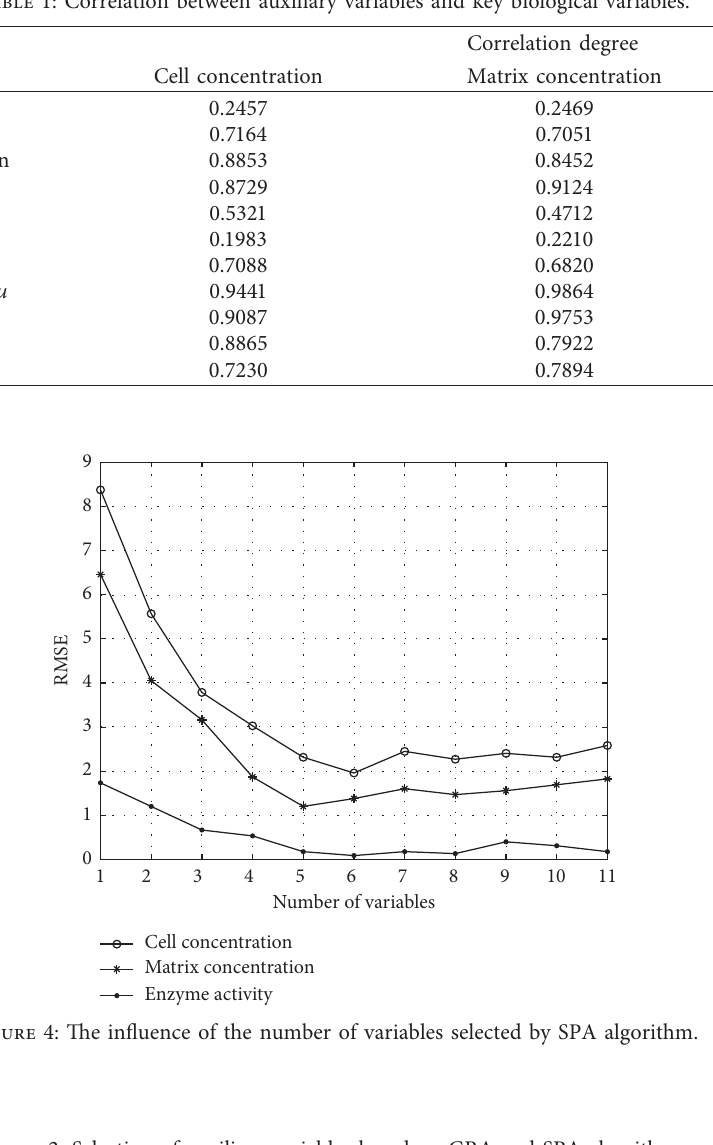
Table 1: Correlation between auxiliary variables and key biological variables.